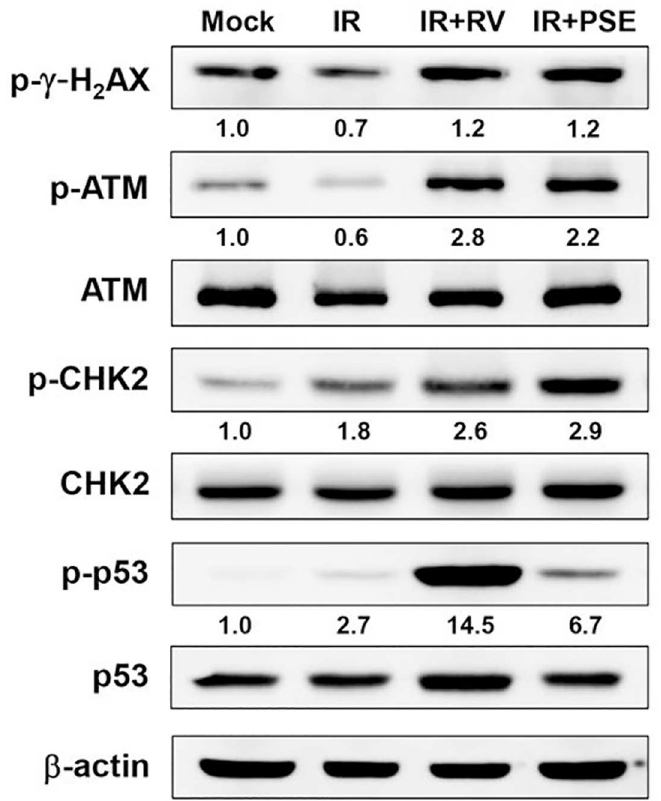
Fig 5. Resveratrol (RV) and peanut stem extract(PSE) enhance irradiation (IR)-induces double-strand breaks (DSBs) in radioresistant prostate cancer cells. Protein expressionlevels of target moleculesin LAPC4-KD cells that were untreated (mock), exposedto IR (2Gy) alone,or in combination with RV or PSE (25 or 500 μ g/mL, respectively). Representative western blot results from one of three independentexperiments are shown. β -actinwas the loadingcontrol. Expression level of each protein was quantified using signal intensity and indicatedbeloweach